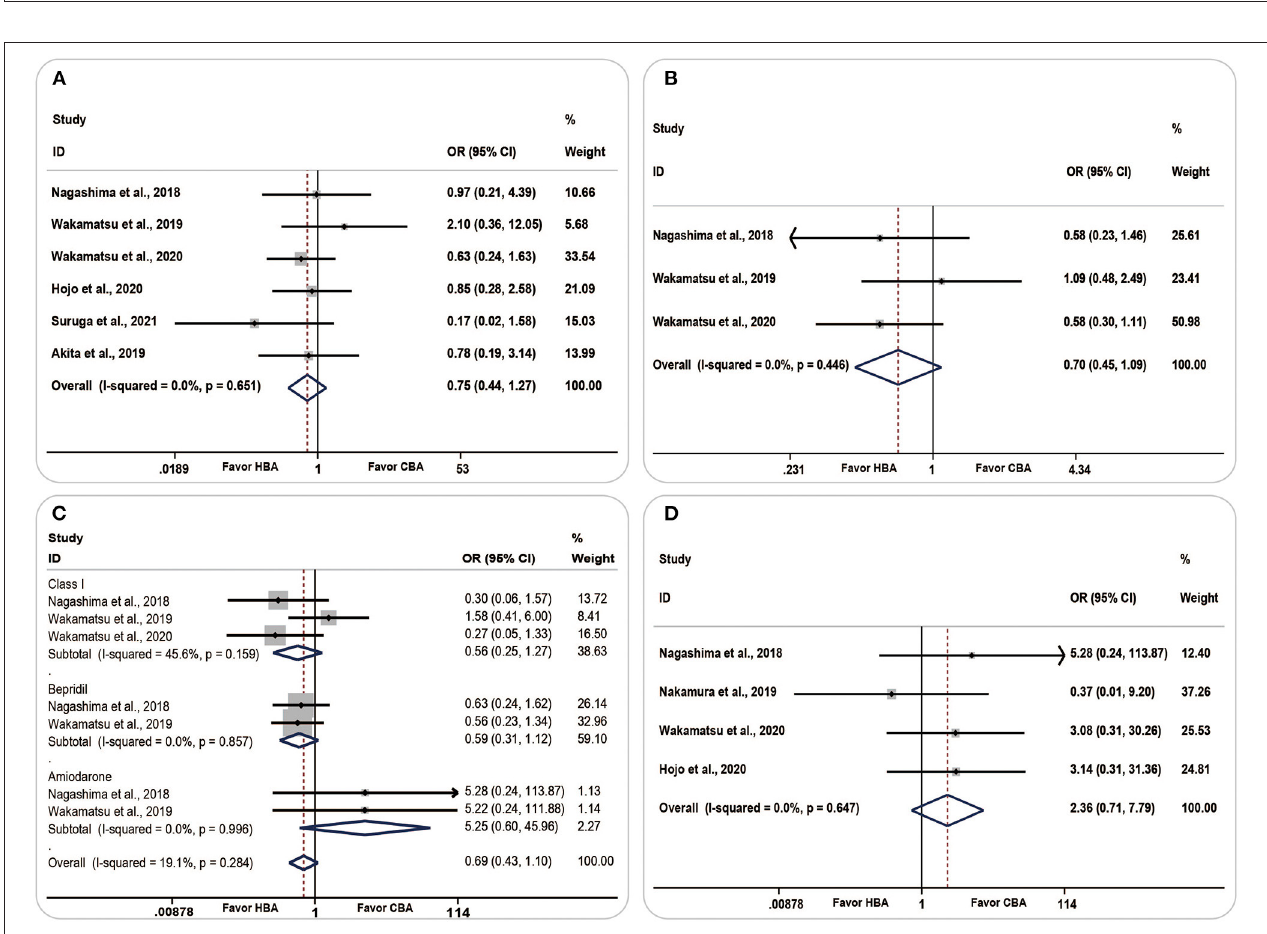
FIGURE 6 | Fluid injected into the hot balloon (Mean ± standard deviation). The above table and diagram summarize the amount of fluid injected into the left atrial pulmonary veins during the hot balloon procedure. As shown in the chart, the LSPV and RSPV received more fluid injections during the procedure. LIPV, left inferior pulmonary vein; RIPV, right inferior pulmonary vein; RSPV, right superior pulmonary vein; RIPV, right inferior pulmonary vein; SD, standard deviation.